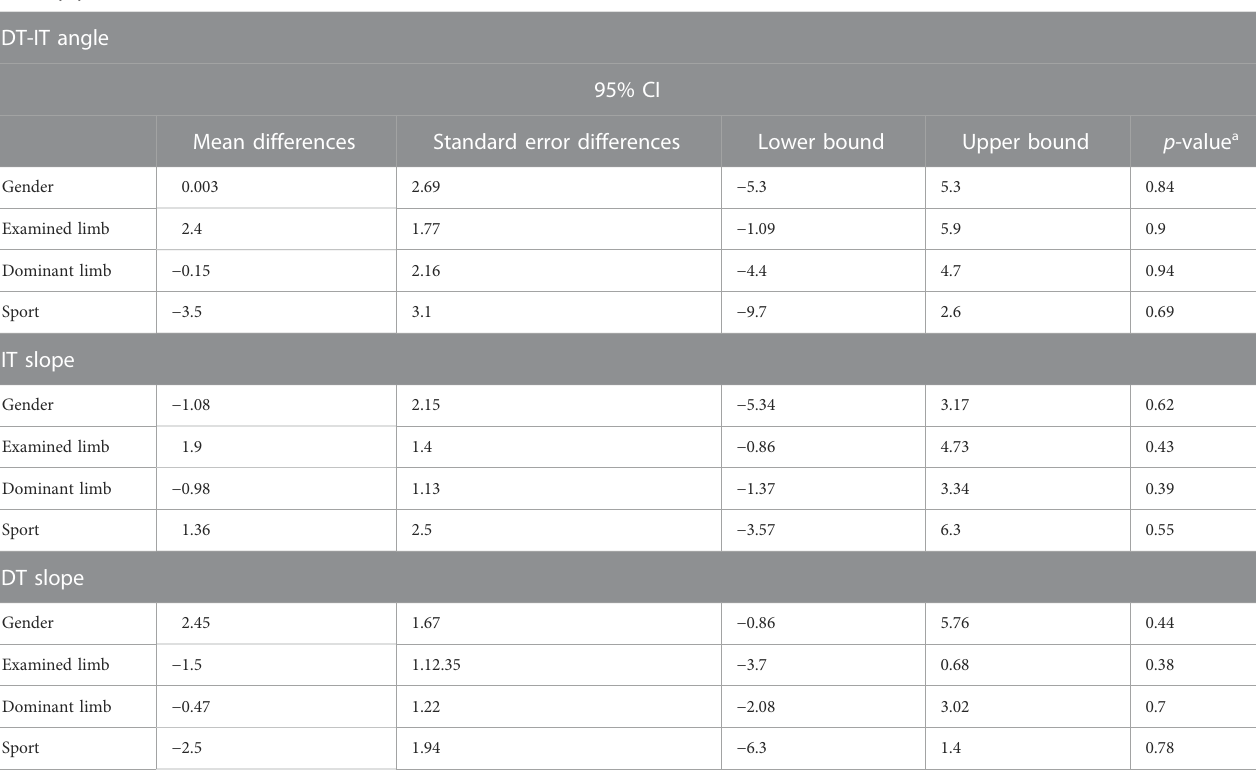
TABLE 4 Statistical Student ’ s t- test correlation of the DT-IT angle, IT slope, and DT slope measured by observer 1 with demographic factors, including 95% con fi dence interval (CI). DT-IT